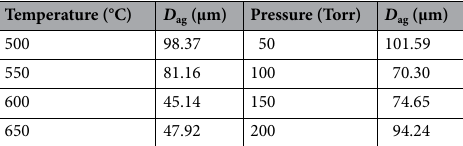
Table 1. The average particle size ( D ag ) of the as-prepared In 2 S 3 thin films at different annealing conditions.